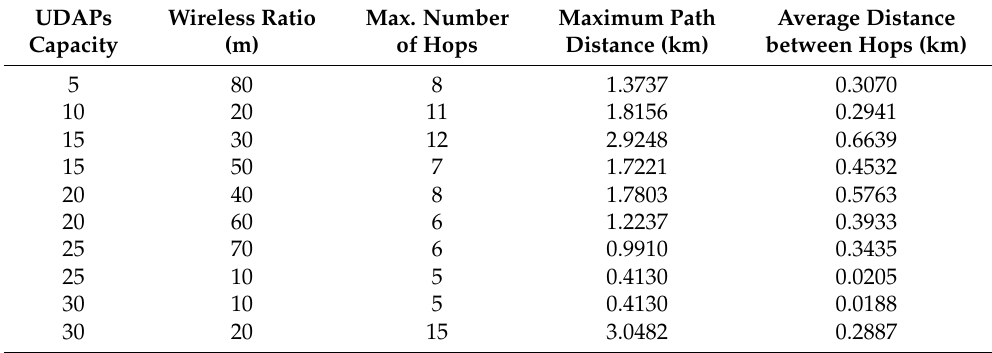
Table 4. Maximum number of hops and resulting maximum distances, depending on the capacity of the UDAPs and the connection distance of the SMs.